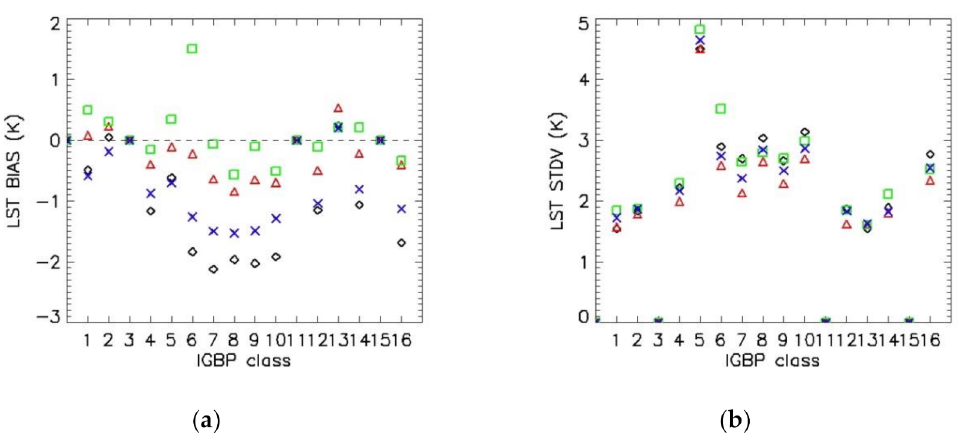
Figure 7. Bias ( a ) and standard deviation ( b ) values averaged over each IGBP class for the drifted time series (black diamonds) and the corrected time series C0, C1, and C2 (red triangles, green squares, and blue crosses,